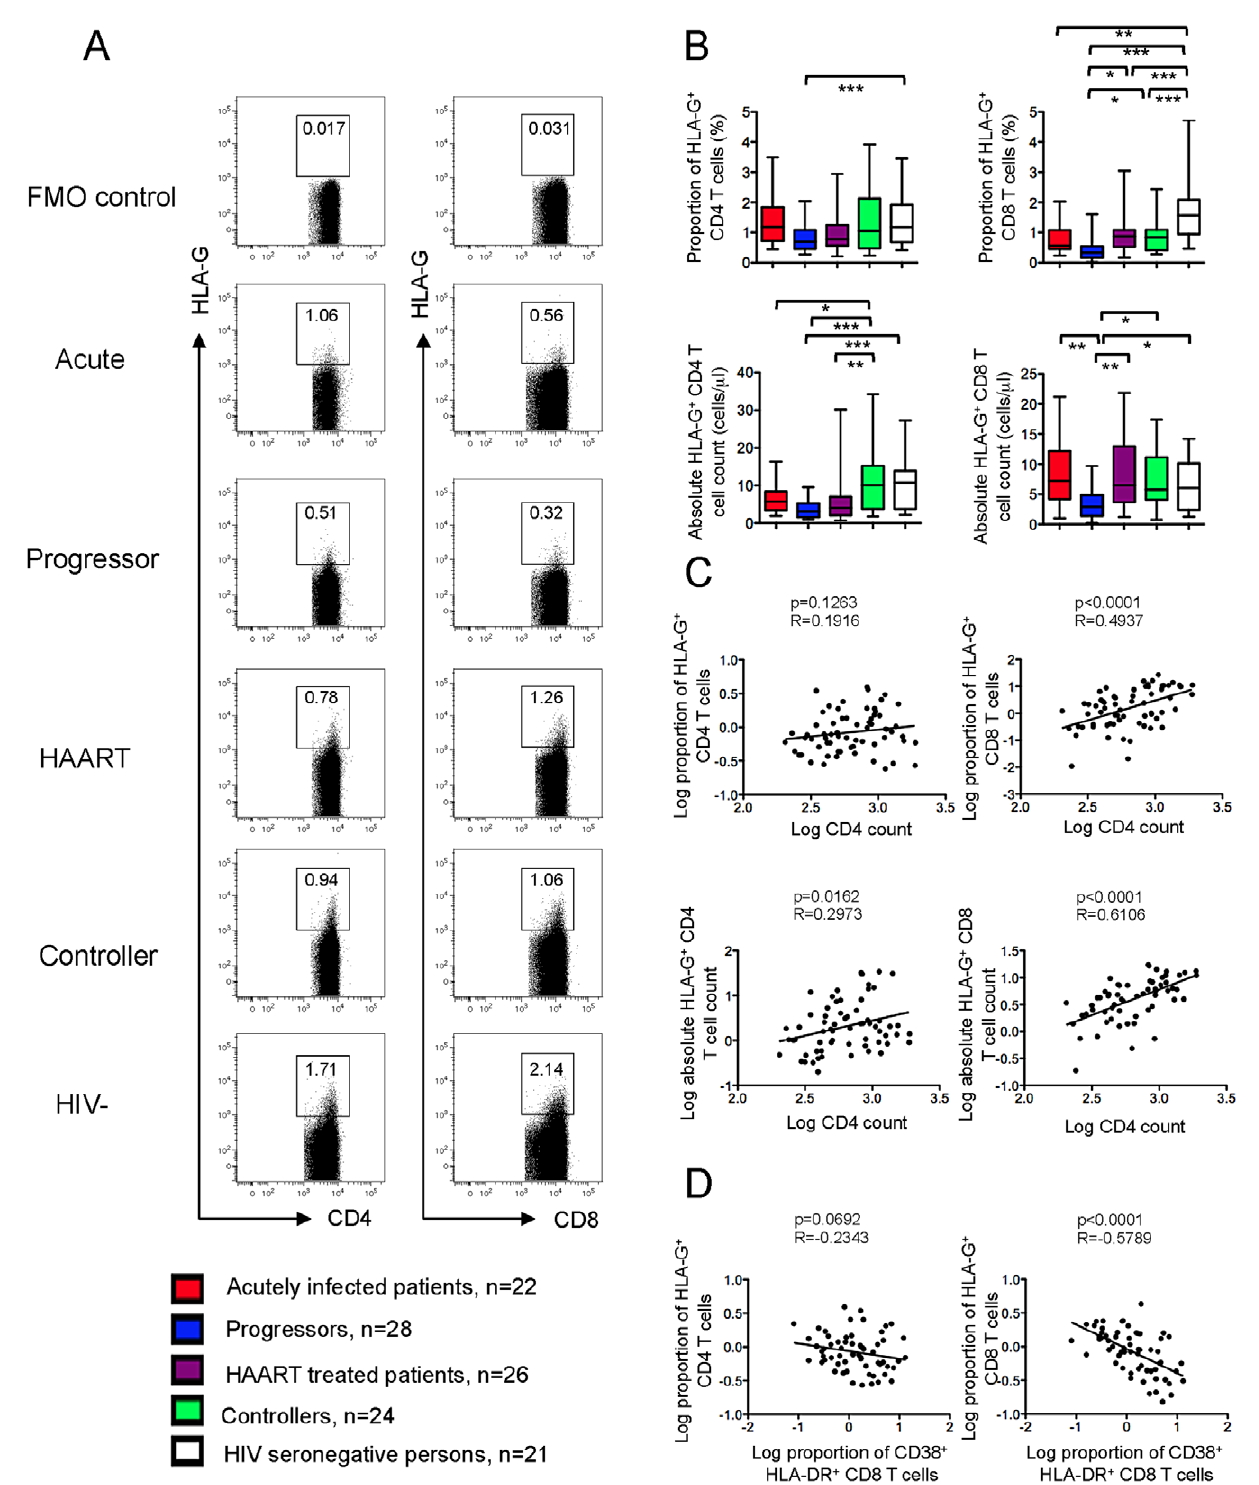
Figure 1. Diminished proportions of HLA-G + CD4 and CD8 T cells in progressive HIV-1 infection. (A): Representative flow cytometry dot plots reflecting the proportions of HLA-G + CD4 and CD8 T cells in indicated study subjects. FMO control reflects ‘‘fluorescence minus one’’ control condition without addition of HLA-G antibodies. (B): Box and Whisker plots summarizing the relative proportions and absolute numbers of HLA-G + CD4 and CD8 T cells in indicated study cohorts. ANOVA followed by post-hoc analysis with Tukey’s Multiple Comparison Test was used to determine significance. (C): Correlationsbetween frequencies of HLA-G + T cells and total CD4 T cell counts in controllers(n=23), progressors (n=27) and HIV seronegative individuals (n=15).(D):Correlations betweenproportions ofHLA-G + Treg andCD8T cellimmuneactivationdetermined bysurfaceexpressionofCD38andHLA-DRin controllers (n=19), progressors (n=20), and HIV seronegative individuals (n=15). (C/D): Spearman’s correlation coefficient is shown.